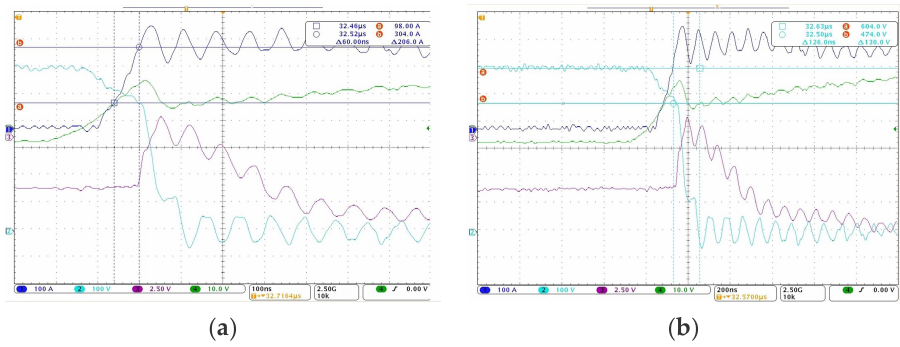
Figure 14. ( a ) ΔI of the test waveform under the conduction condition of 600 V/300 A; ( b ) ΔU of the Figure 14. ( a ) ∆ I of the test waveform under the conduction condition of 600 V/300 A; ( b ) ∆ U of the test waveform under the conduction condition of 600V/300A. test waveform under the conduction condition of 600 V/300 Table 4. Stray inductance test data of bus.